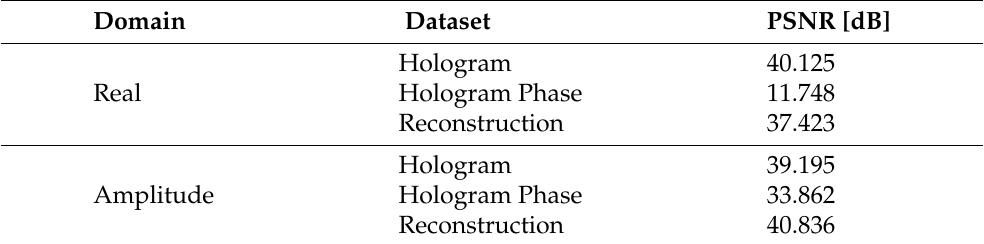
Table 3. Invisibility of the hologram and reconstruction with reconstruction in